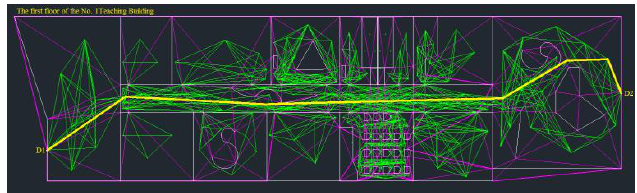
Figure 15. Resulting network for navigation (green) and the shortest path (bold yellow)